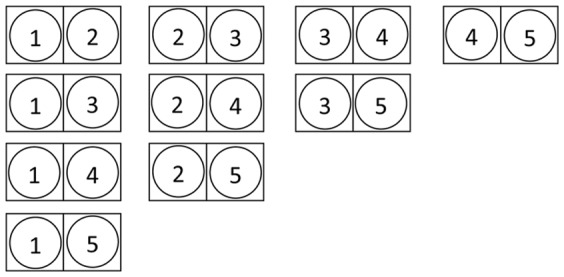
Reflection symmetry.Enumeration of all possibilities to map 5 network nodes on 2 reflection symmetric motif nodes. The squares represent motif nodes, the circles represent network nodes. Once a network node has been mapped on a motif node that is part of a reflection symmetry, it will never be mapped on one of the other nodes of the symmetry.